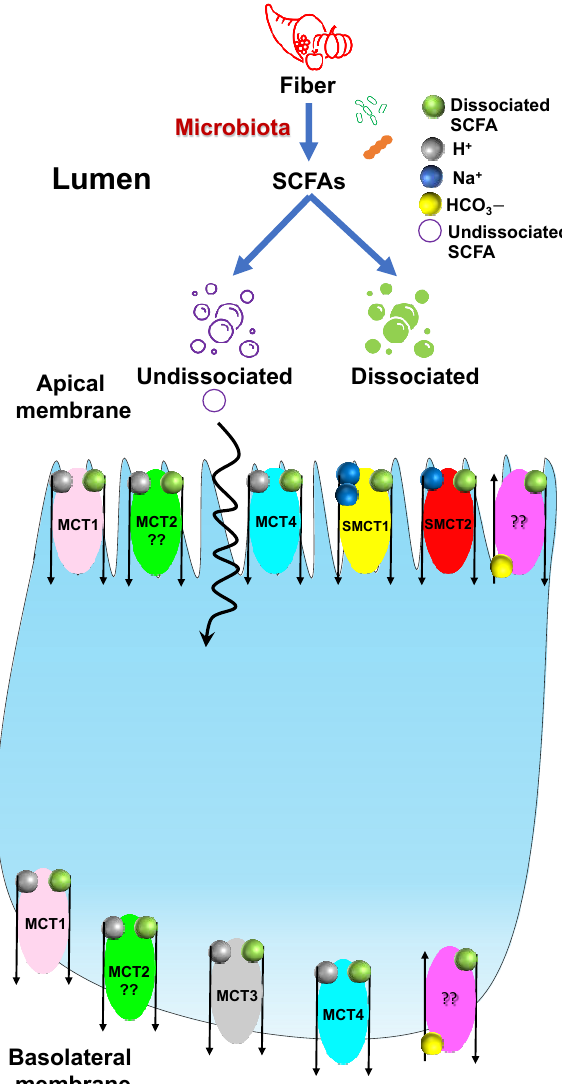
Figure 3. An overview of SCFA transport mechanisms. SCFAs produced in the gut lumen by the gut flora exist in two forms: undissociated and dissociated SCFAs. Undissociated SCFAs can pass across the apical plasma membrane by passive diffusion while the dissociated SCFAs require the aid of transporters. MCT1 – 4, Monocarboxylic acid transporters (shown in light-pink, green, grey, and blue); SMCT1 – 2, Sodium-coupled monocarboxylate transporter (shown in yellow and red); SCFA/HCO 3 − exchangers (shown in magenta).